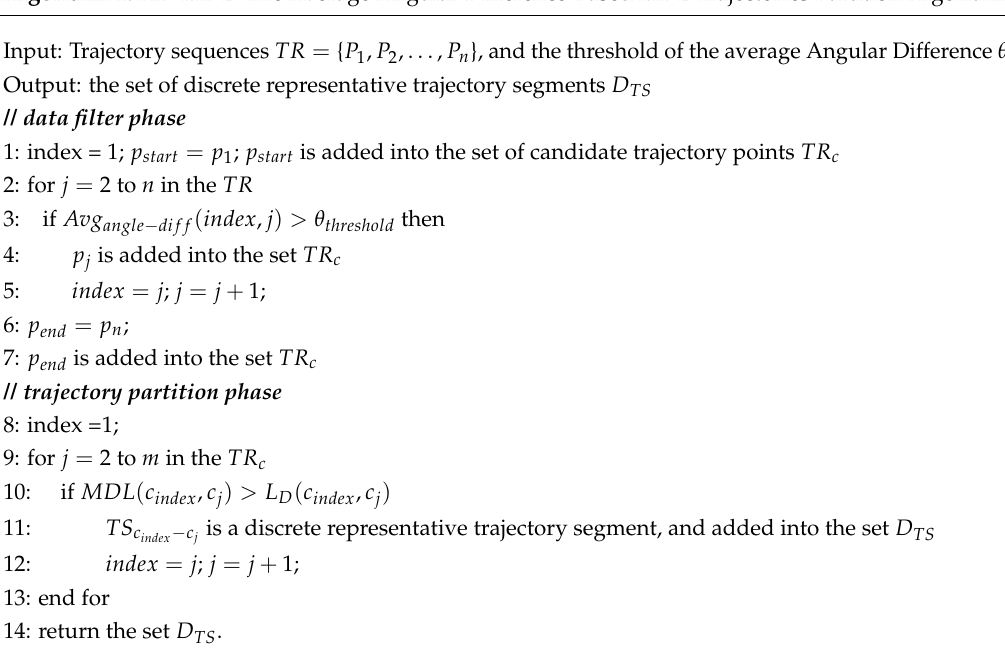
Algorithm 1. AD-MDL: The Average Angular Difference-Based MDL Trajectories Partition